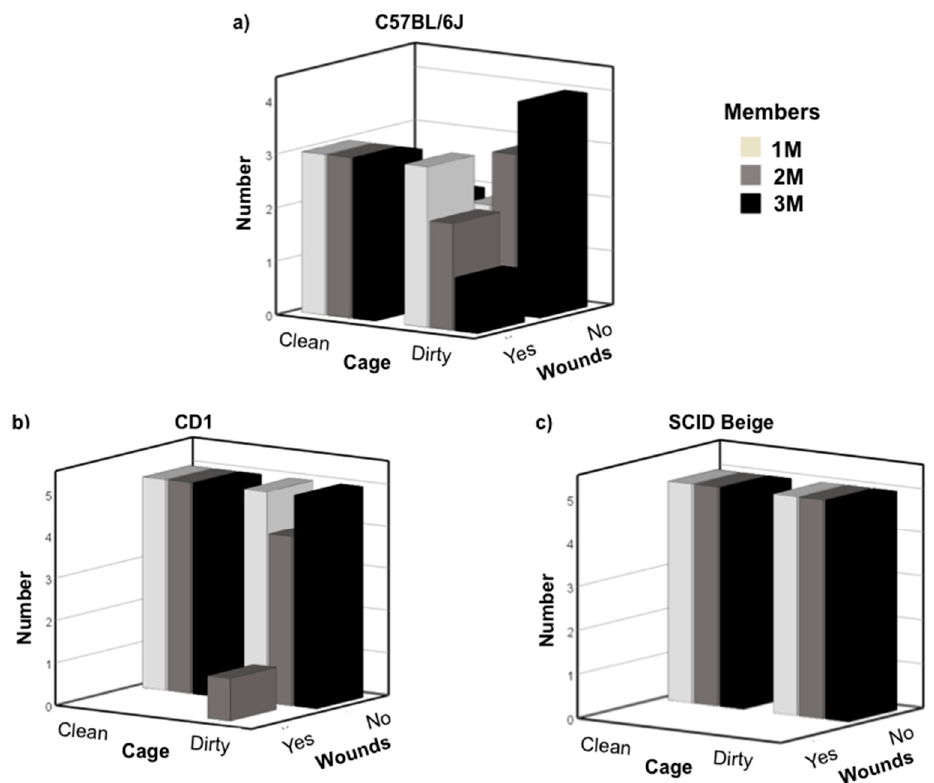
Figure 3. Number of cages in which wound due to fights were observed: ( a ) C57BL/6J ( b ) CD1, and ( c ) SCID Beige newly weaned mice after grouping with late pubescent male mice. X-axis shows the condition of the cage, clean or dirty. Z-axis shows whether there were or were no wounds due to fights. White bars indicate cages with one member; grey bars two members and black bar three members’ cages. A total of 30 cages per strain were analyzed—five cages per condition.